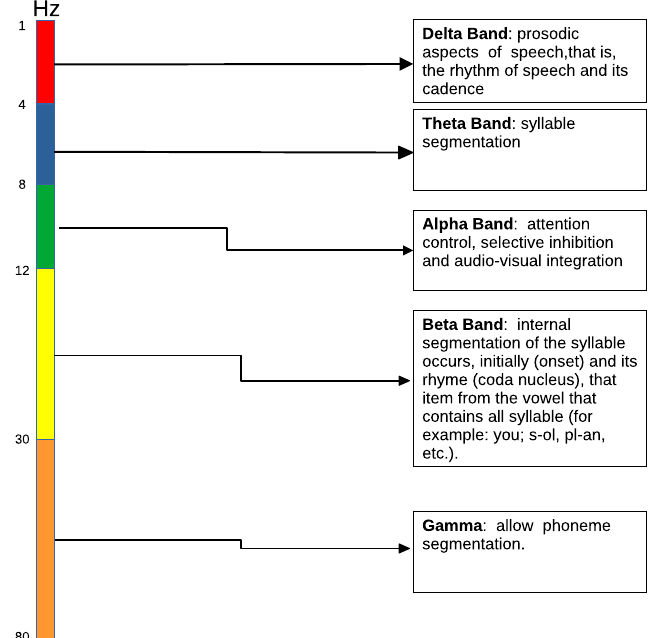
Figure 2. Five main electrophysiological (EEG) frequency bands